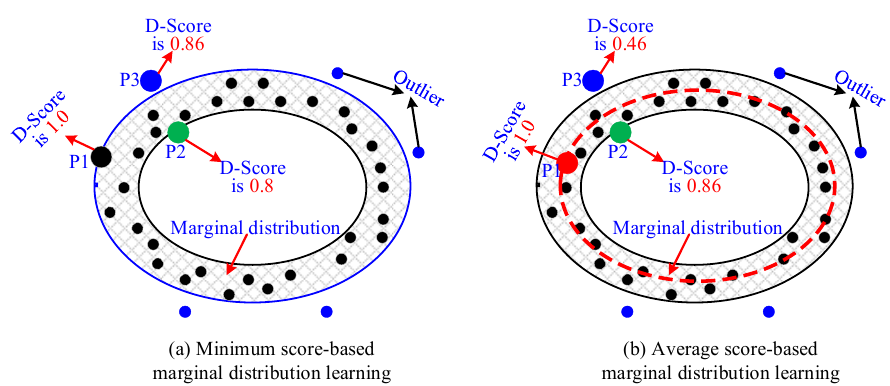
Figure 4. Optimization strategy for threshold μ .